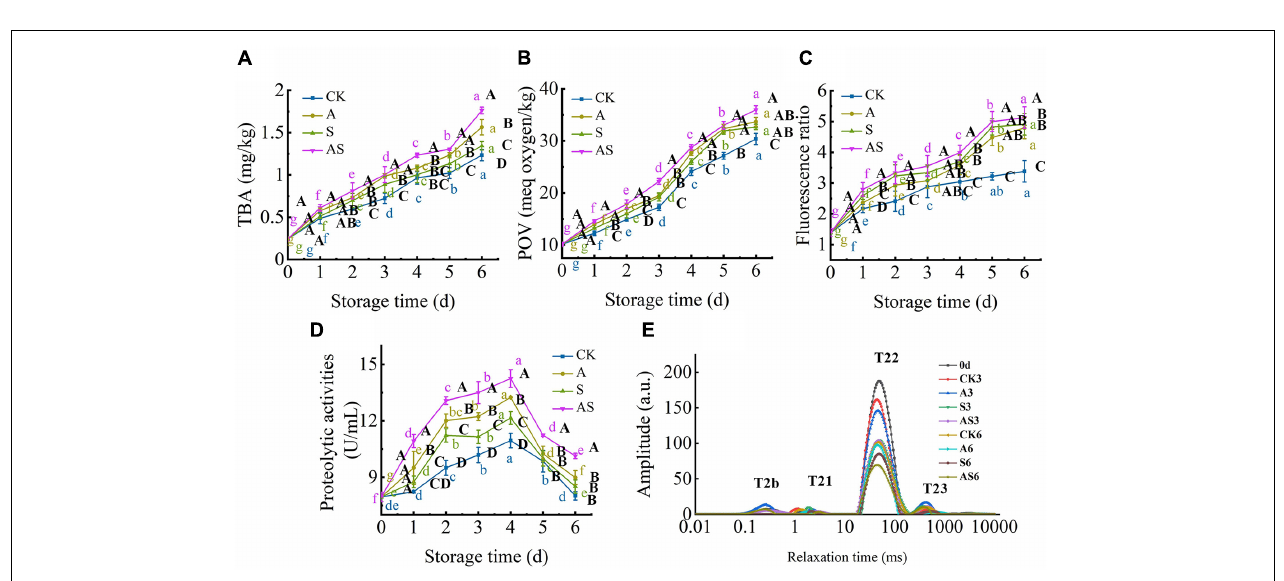
FIGURE 2 | Scanning electron microscopy (SEM) photographs of bigeye tuna muscle stored at 4 ◦ C for 0 day (A) , stored at 4 ◦ C in the control group for 6 days (B) , stored at 4 ◦ C in the A group for 6 days (C) , stored at 4 ◦ C in the S group for 6 days (D) , and stored at 4 ◦ C in the AS group for 6 days (E) .